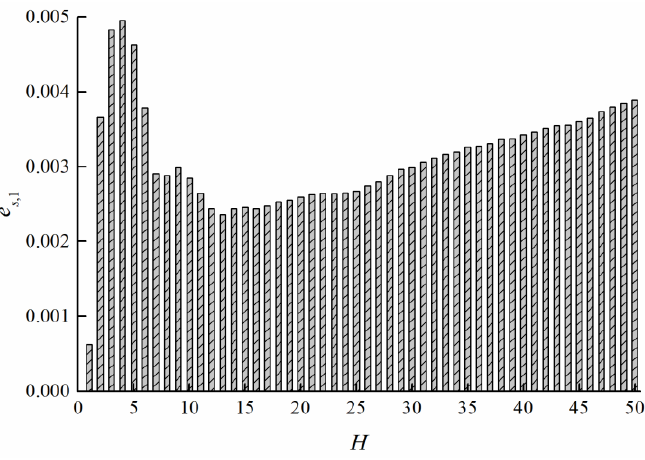
Figure 9. The relationship between the model prediction accuracy and the prediction depth. Figure 10 compares the dynamic process simulation curves of the component-level model and the trained dynamic prediction model performing the same control task under the same control policy. Except for the same initial state, there is no data and information transmission between the component-level model, and the dynamic prediction model in the subsequent process. With the 2500 simulation steps, the prediction accuracy of the dynamic prediction model is not affected by error accumulation, and the whole simula- tion process has high prediction accuracy. Compared with the steady state process, the prediction accuracy of the transition state process is higher. The reason, we guess, is that the samples in the replay buffer are mostly transitional process data, which leads to more adequate training in fitting the transitional process. In Figure 10, the simulation curves of S , m f